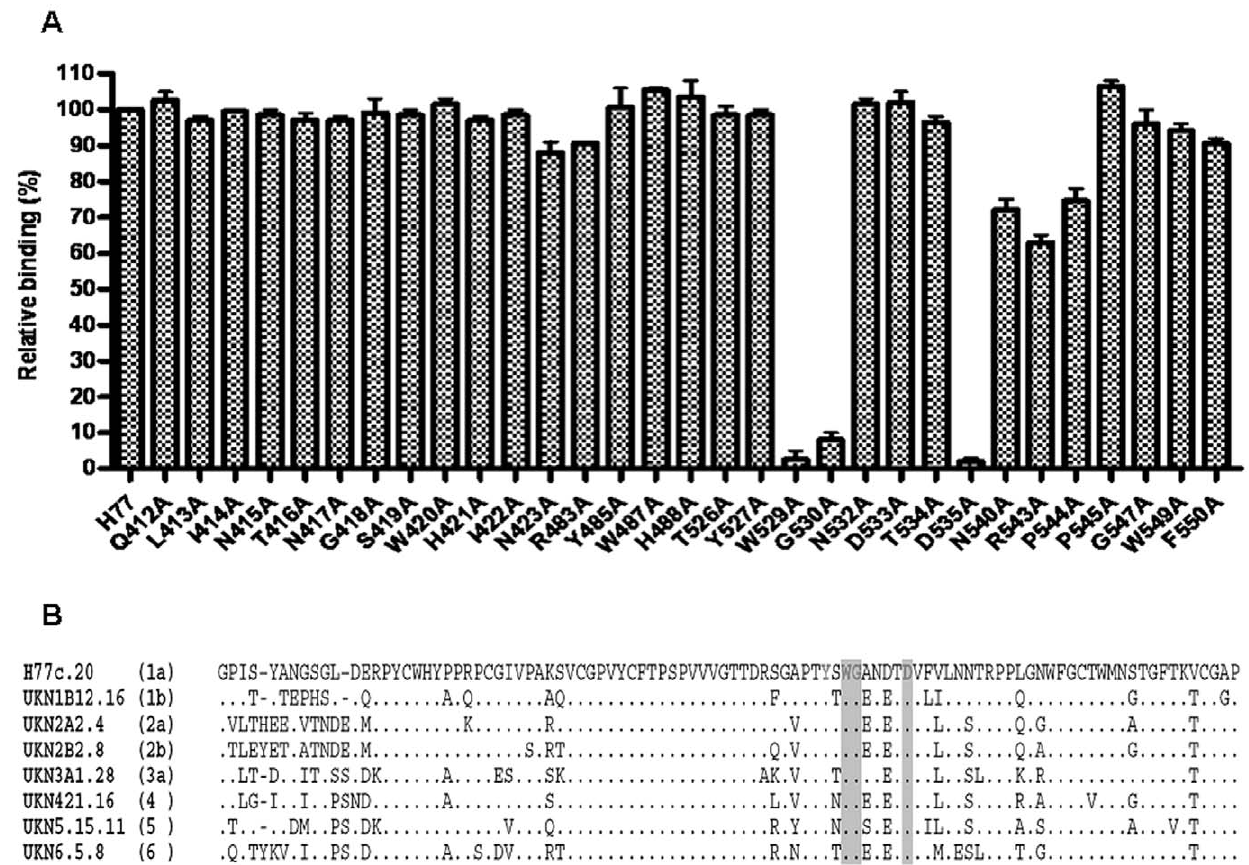
Figure 2. Residues recognized by Fab e20 on HCV/E2. ( a ) Reactivity of Fab e20 on a panel of mutated E1E2 glycoproteins derived from H77 strain. Binding activity, expressed as a percentage of the reactivity on wild type E1-E2 (H77 strain), is shown on the y axis; the mutated residues are shown on the x axis. Fab e20 was tested at 10 m g/ml. The means and standard errors of two independent assays are reported. ( b ) HCV/E2 partial sequence alignment of the HCV strains used in this study. The genotype of each strain is reported in brackets. Residues Y527, W529, G530 and D535 abrogating the binding to CD81 are depicted in red. Shaded grey boxes evidence the conserved residues recognized by e20.